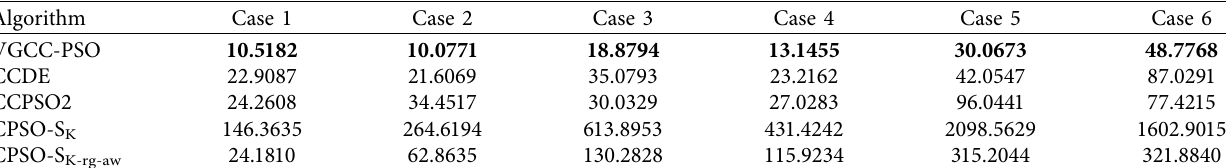
Table 3: Simulation results for Case 1 to 6.